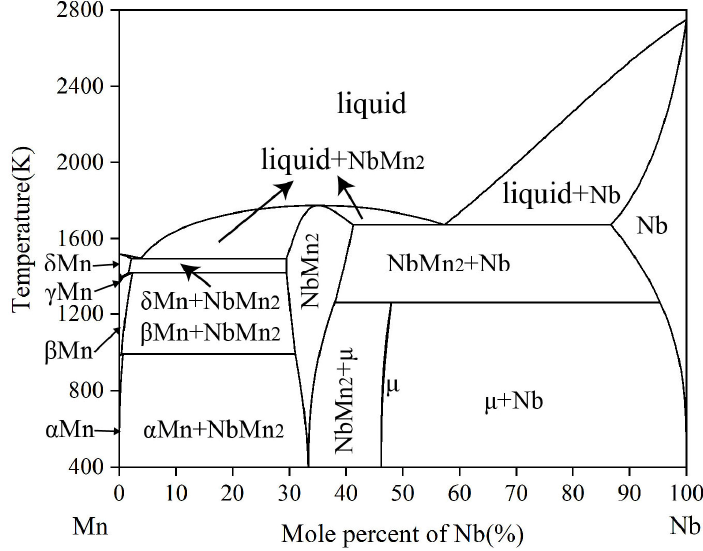
Figure 2. The calculated Mn-Nb phase diagram based on the work of Liu et al. [18]. The Ti-Nb phase diagram has been investigated by several groups [22–27]. Bellen et al. [22], Zhang et al. [26] and Matsumoto et al. [27] made a critical evaluation of this